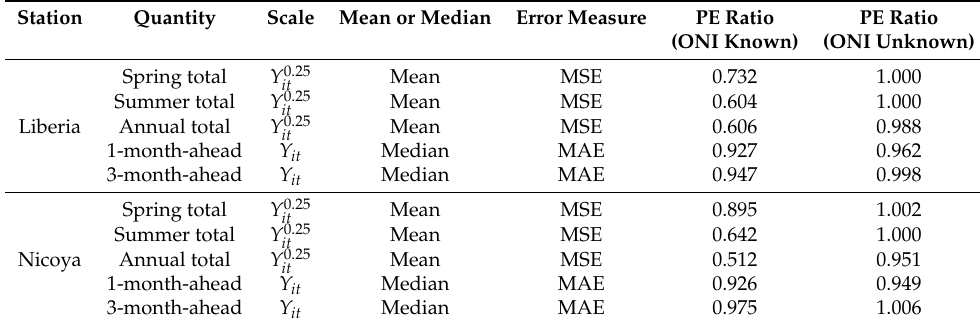
Table 5. Ratio of the prediction error (PE) based on the regression model with AR(1) errors (where ONI may be assumed known or unknown) to that based on the naive method (sample means/medians by month).